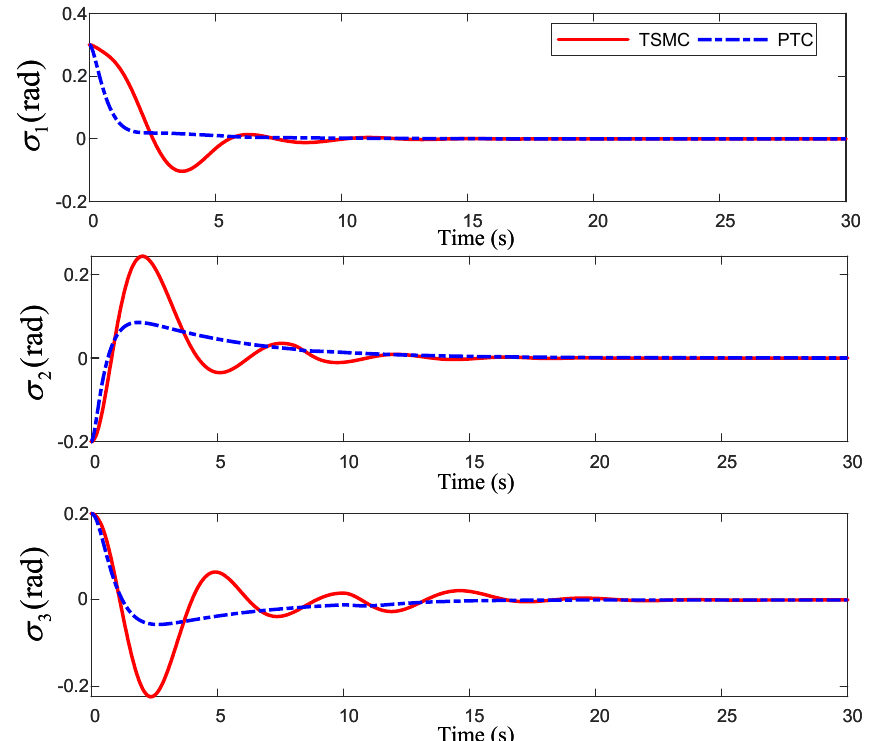
Figure 5. The response of attitude angle tracking performance.